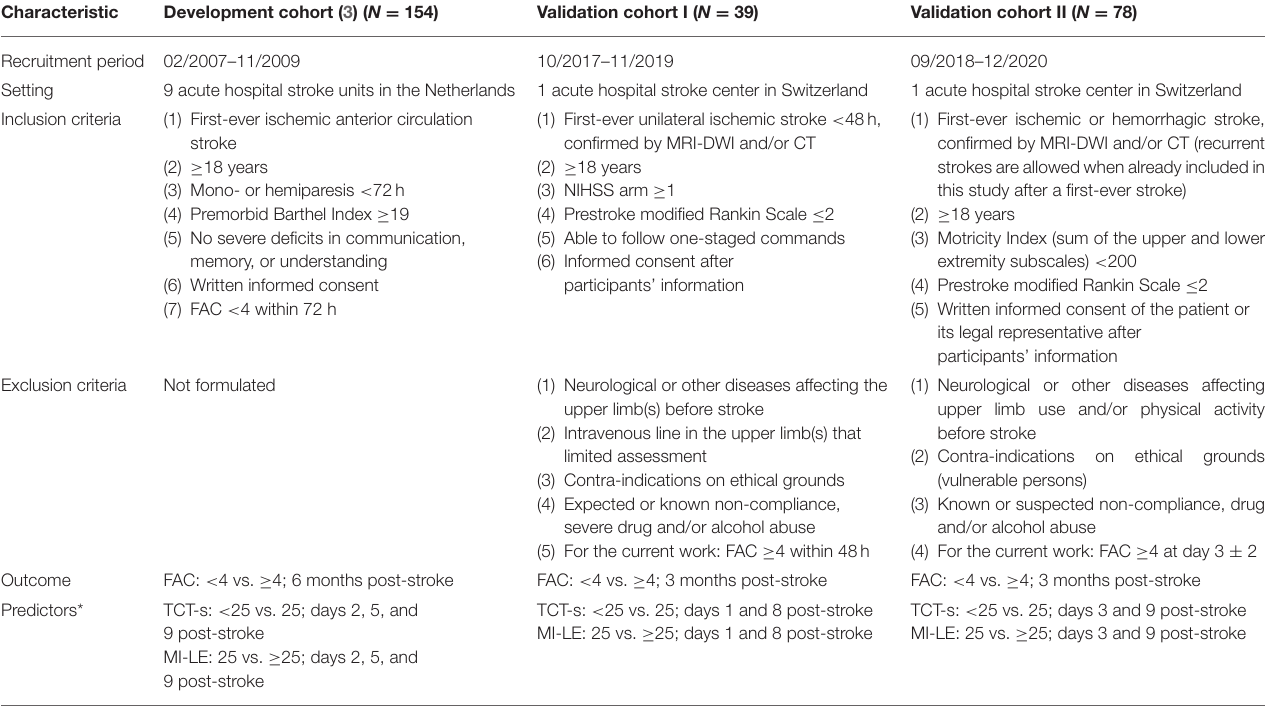
TABLE 1 | Key characteristics of the development and validation